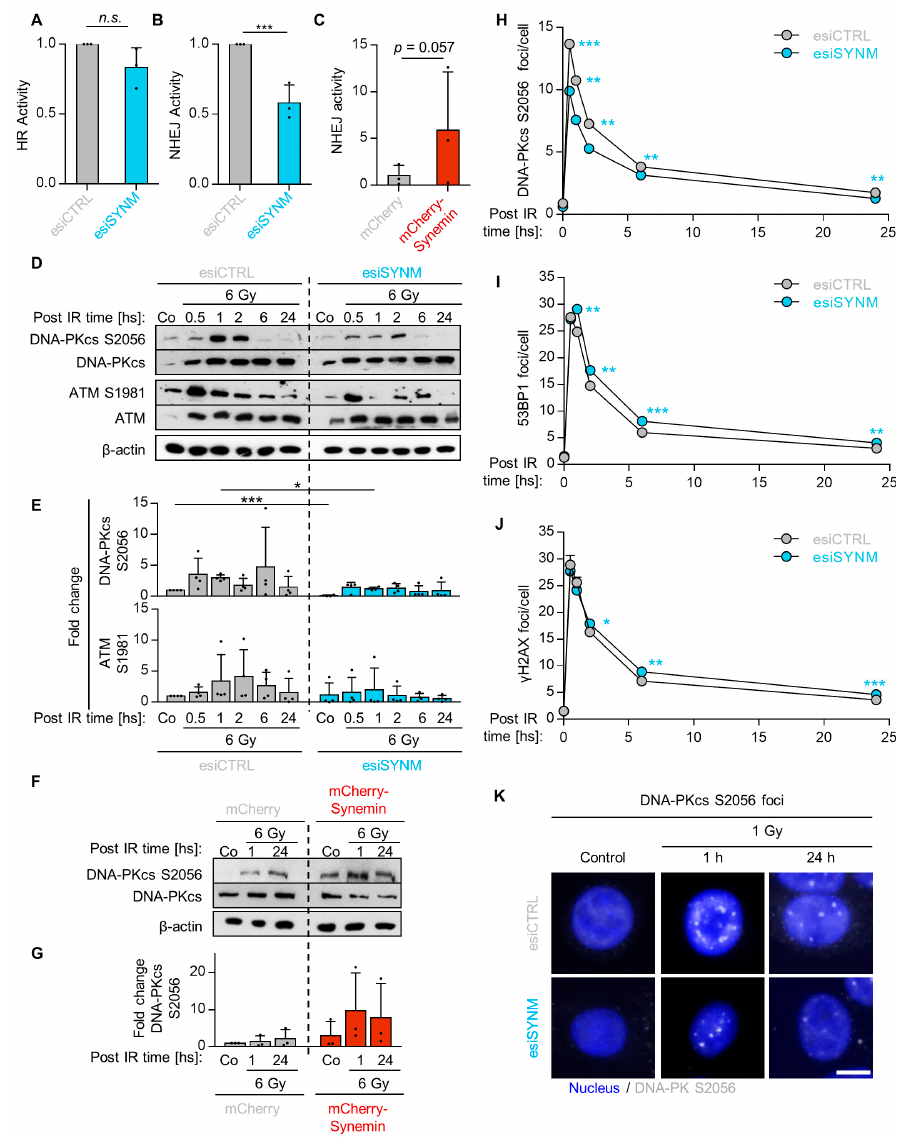
Figure 3. Synemin functions in non-homologous end joining. GFP-based reporter assays for ( A ) HR and ( B ) NHEJ. Cal33 cells stably transfected with DRGFP or pimEJ5GFP recombinant plasmids were depleted of synemin. The number of GFP-positive cells was analyzed by FACS, provided in Supplementary Figure S5A; ( C ) NHEJ activity in mCherry–Synemin-overexpressing Cal33-pEJ5GFP cells. Analysis performed by FACS as indicated under ( A , B ); ( D , E ) Immunoblots and fold changes from synemin-depleted and 6-Gy irradiated SAS cells showing total and/or phosphorylated forms of DNA-PKcs, ATM. β -actin served as loading control; ( F , G ) Immunoblot and fold change of DNA-PKcs from whole cell lysates of 6-Gy X-ray irradiated and mock-treated SAS mCherry–Synemin transfectants. β -actin served as loading control; ( H–J ) Kinetics of DNA-PKcs S2056, 53BP1 and γ H2AX foci upon synemin knockdown at different time-points post 1-Gy X-rays in SAS cells; ( K ) Representative immunofluorescence images of residual DNA-PKcs S2056 foci of synemin knockdown and control cell cultures 1 h after 1-Gy X-rays (bar, 10 µ m). Data are presented as mean ± SD ( n = 3; two-sided t -test; ** p < 0.01, *** p < 0.001; n.s., not significant ( p ≥